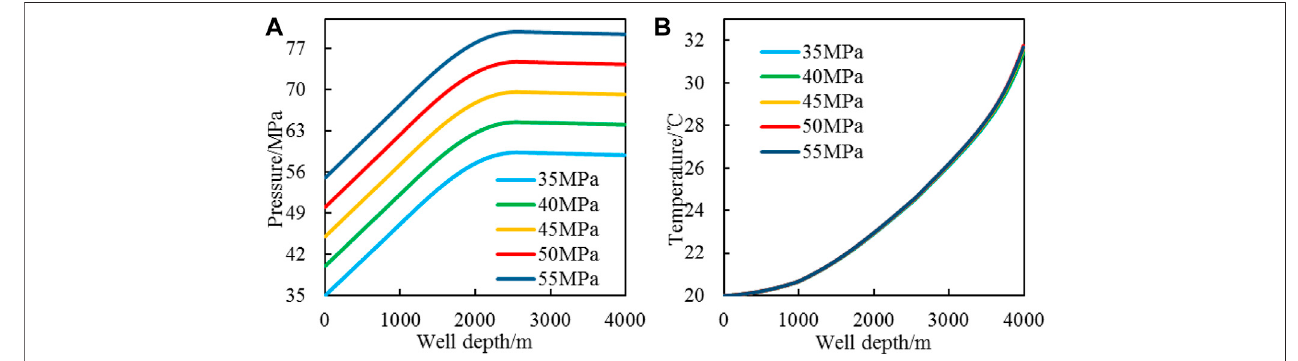
FIGURE 7 | CO 2 foam fracturing fl uid pressure and temperature change with injection pressure [ (A) : pressure pro fi le; (B) : temperature pro fi le].